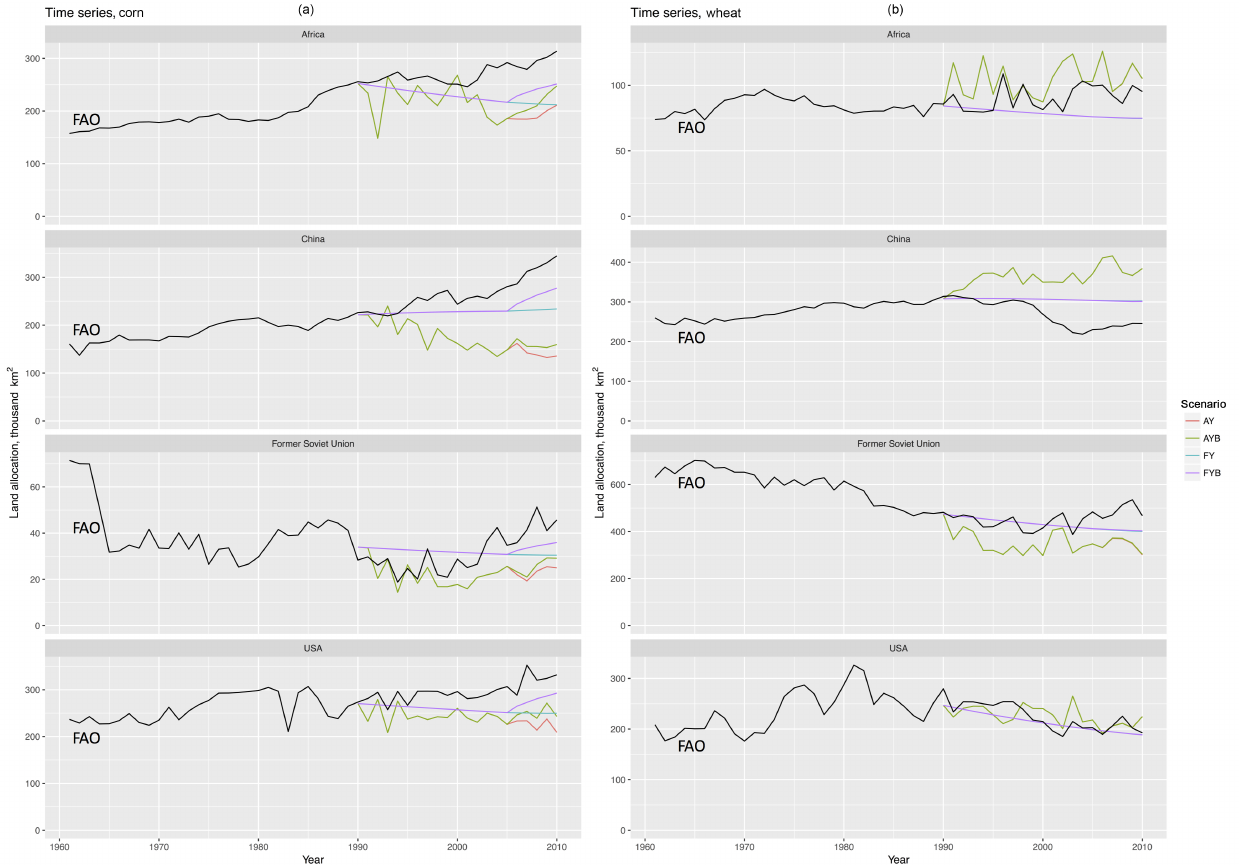
Figure 7. Time series for land allocated to corn (a) and wheat (b) in units of thousands of square kilometers across select regions. The black time series in each panel represents FAO observational data. The colored time series correspond to different GCAM